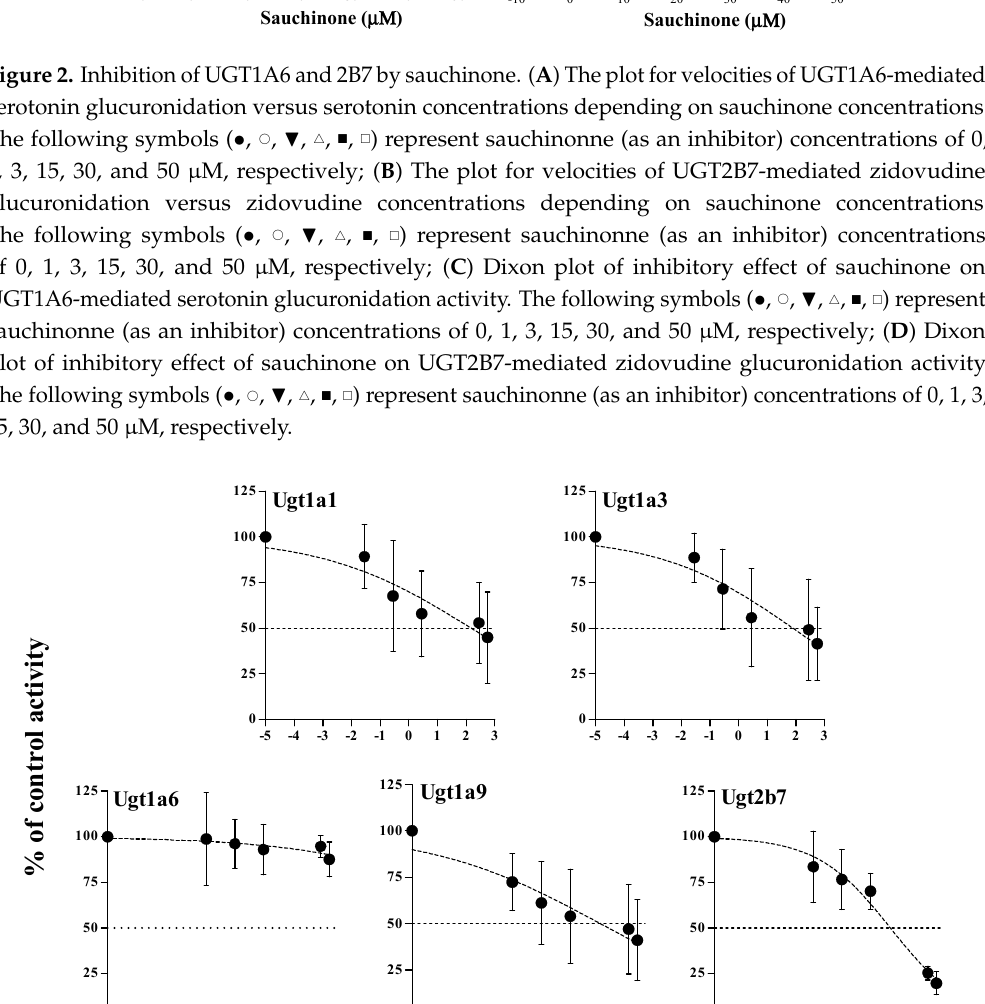
Figure 3. IC 50 curves for the direct inhibition of Ugt1a1, Ugt1a3, Ugt1a6, Ugt1a9, and Ugt2b7 in MLM. The ‘ ● ’ represents the remaining percentage of UGT-mediated metabolic activity with sauchinone as an inhibitor versus control (without sauchinone). ( n = 3 for each group).